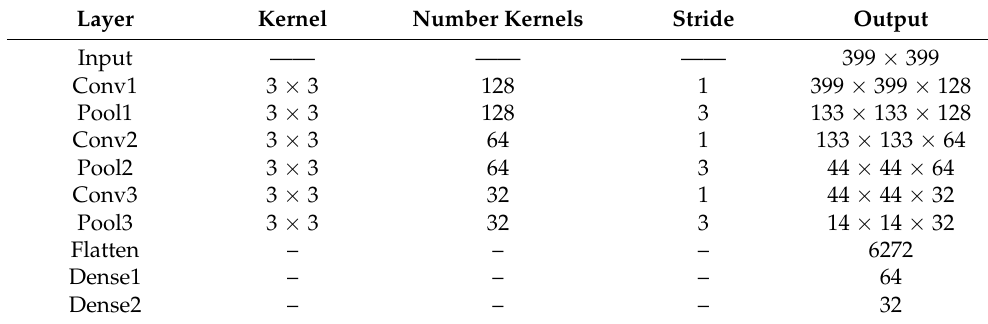
Table 3. The structure parameters of 2D-CNN.